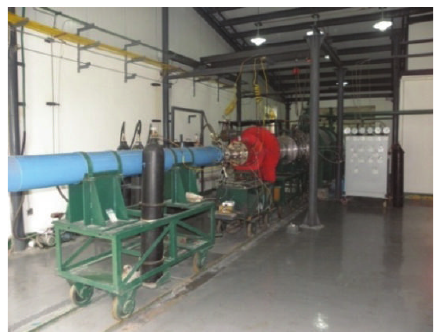
Figure 1: Photo of pulse combustion wind tunnel [7, 8].